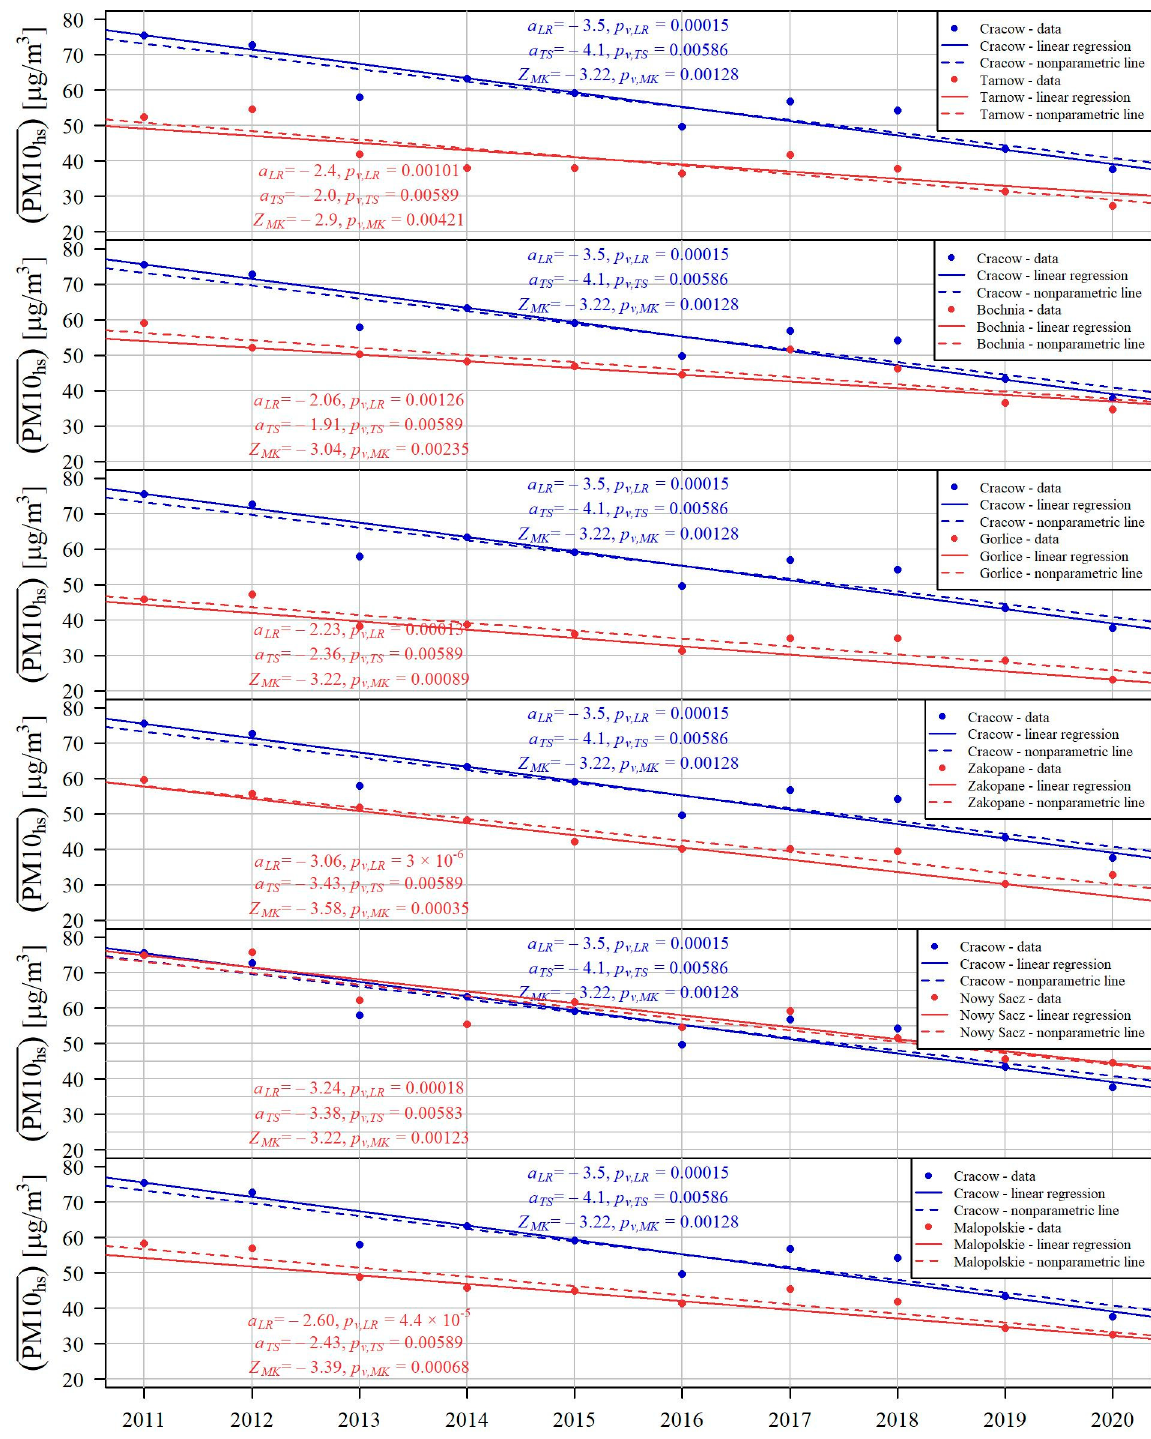
Figure 6. Comparison of the distributions of average annual concentrations of PM10 hs for the heating season in Cracow and the analyzed cities of the Malopolskie Voivodeship in 2011–2020. Significant ( p v , MK < 0.05) decreasing trends shown using Theil–Sen line with significant slope a TS [µg/m 3 /year] ( p v , TS < 0.05). Linear regressions with significant a LR [µg/m 3 /year] ( p v , LR < 0.05) are shown for comparison. Malopolskie means the arithmetic mean of the values for individual analyzed cities, excluding Cracow. (Source: own elaboration based on the data from the database of the Chief Inspectorate for Environmental Protection [29]).